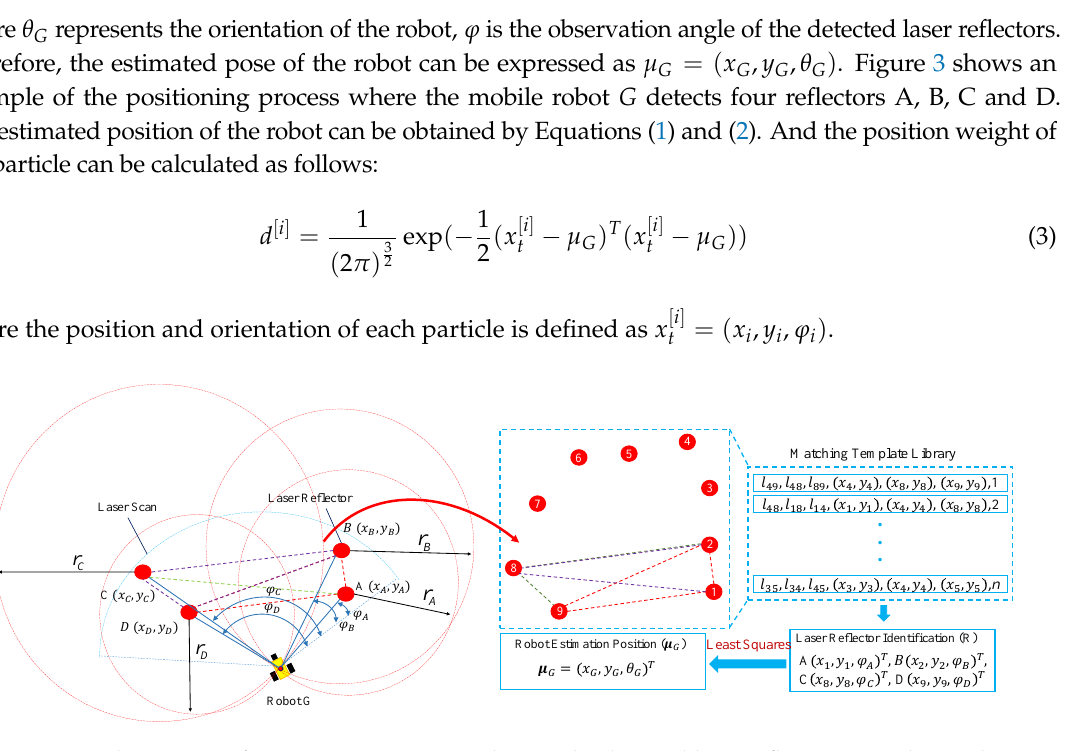
Figure 3. The process of positioning. A, B, C and D are the detected laser reflectors. ϕ and r are the observation angle and detection distance of the detected laser reflector, respectively. G is the mobile robot. θ G is the orientation of the robot based on the observation angle of the detected laser reflectors. µ G is the estimation position of the